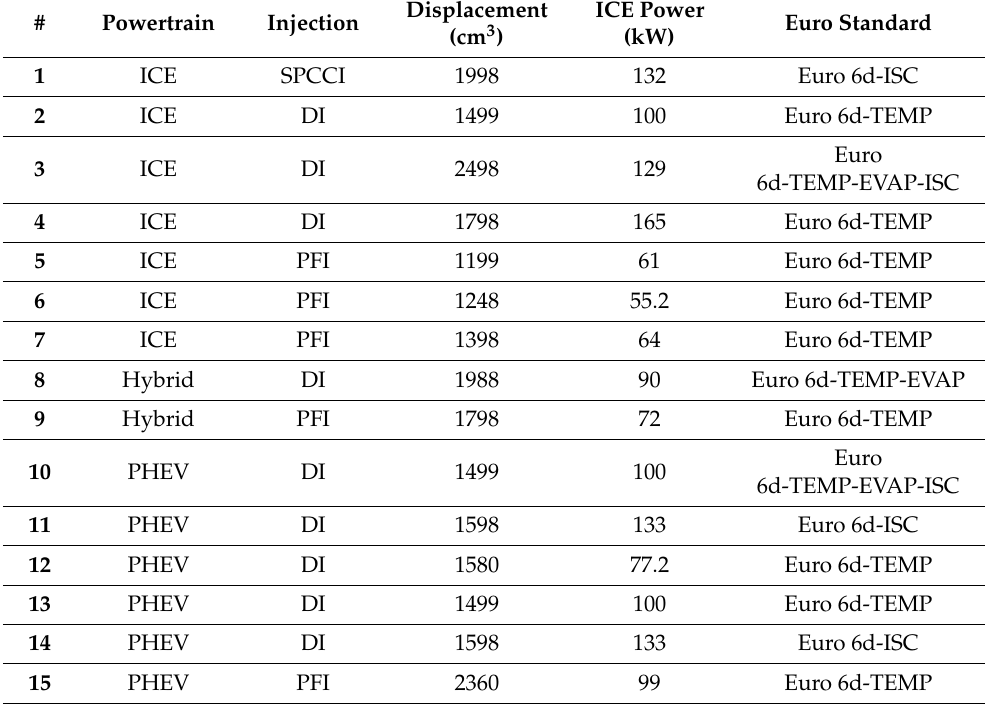
Table 1. Characteristics of the vehicles tested; ICE: conventional internal combustion engine, hybrid: hybrid engine, PHEV: plug-in hybrid engine. DI: direct injection, PFI: port fuel injection, SCCI: spark-controlled compression